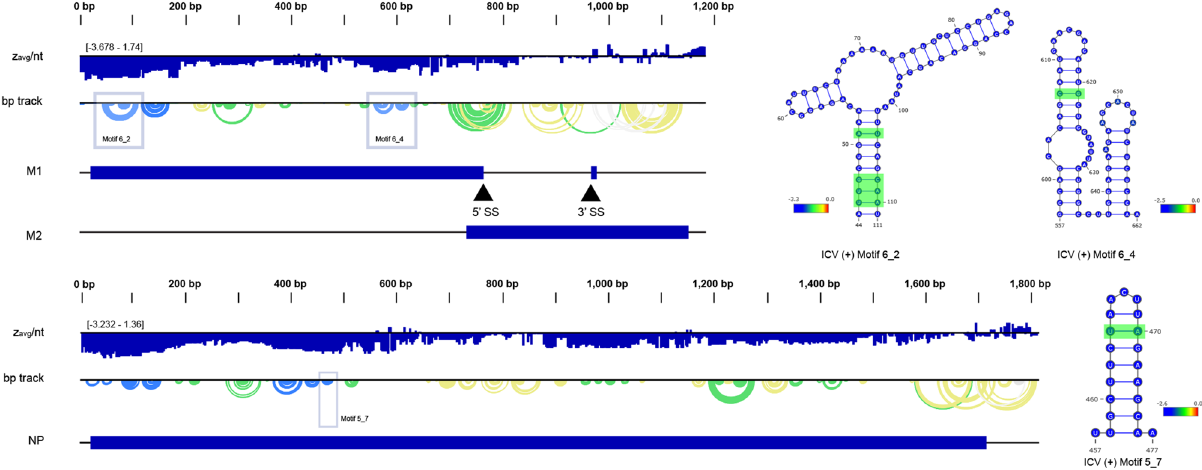
Figure 4. ScanFold analysis for motifs ICV ( +) 6_2 and 6_4 (blue boxes, upper panel) and 5_7 (lower panel). The base pair track (bp track) shows arcs correlating to base pairings, where blue arcs have a < −2 score, green arcs have a < −1 z-score, yellow arcs have a < 0 z-score, and gray arcs have a z-score > 0. The R-Scape results for ICV ( +) 6_2 had 4 bp observed to covary (highlighted in green) with 0.0 ± 0.1 bp expected, while 6_4 had 1 observed bp with 0.0 ± 0.0 bp expected. ICV ( +) 5_7 showed a single observed bp when 0.0 ± 0.2 were expected. ScanFold per nt z avg are overlaid in each nucleotide circle, with blue designating < −2 z avg . Structural images were adapted from VARNA, and the genome illustrations were adapted from with 0.0 ± 0.0 bp expected (Fig. 4). Only one motif, the 8 bp hairpin ICV ( +) 5_7 (456–477), showed evidence of broad conservation across multiple influenza clades (Fig. 4). ICV ( +) 5_7 showed a single observed covary- ing base pairing when 0.0 ± 0.2 were expected. These results were based on 24 sequences (13 IAV, 11 ICV), all coding for the segment 5 nucleocapsid protein. All 24 sequences align with our IAV 5 ( +) reference sequence from ~ 1139–1165, with the IAV sequences containing up to an 8-nucleotide insertion not seen in ICV. Interest- ingly, this insertion aligns within ICV ( +) 5_7’s hairpin loop without disrupting the existing structure. Looking at IAV ( +) 5 in this region (Supplemental File 2), the ordered motif IAV ( +) 5_4 was predicted in this region (1145–1159), but failed to refold as an individual motif due to only consisting of two base pairs. The global refold Comparison of predicted structures to available DMS-MaPseq data. Using pub- ScanFold licly available probing data for IAV (H1N1 strain) 41 , we were able to conduct a receiver operating characteristic (ROC) analysis comparing DMS-MaPseq data to all ScanFold -1 ΔG z-score predicted structures within all 8 positive-sense IAV segments (see “Methods” for greater detail). Briefly, reactivity values are constrained from lowest to highest values at regular (e.g., 1%) intervals and constrained positions are considered to be paired at their corresponding thresholds. Here, constrained DMS-MaPseq datasets were cross referenced to ScanFold predicted structures to yield a true positive rate (TPR) and a false positive rate (FPR) of prediction. The results of this analysis (Fig. 5 and Supplemental File 4) showed that ScanFold predicted structures had a non-random fit and agreed well with the probing data. In an ROC analysis, the area under the curve (AUC) is a measure of how well the data fit and an AUC value of 0.5 would indicate a random fit and a value of 1.0 would indicate a perfect fit. ScanFold predicted structures for all 8 IAV segments had AUCs which ranged from 0.63 for segment 4 and up to 0.83 for segment 8 (Fig. 5). Discussion